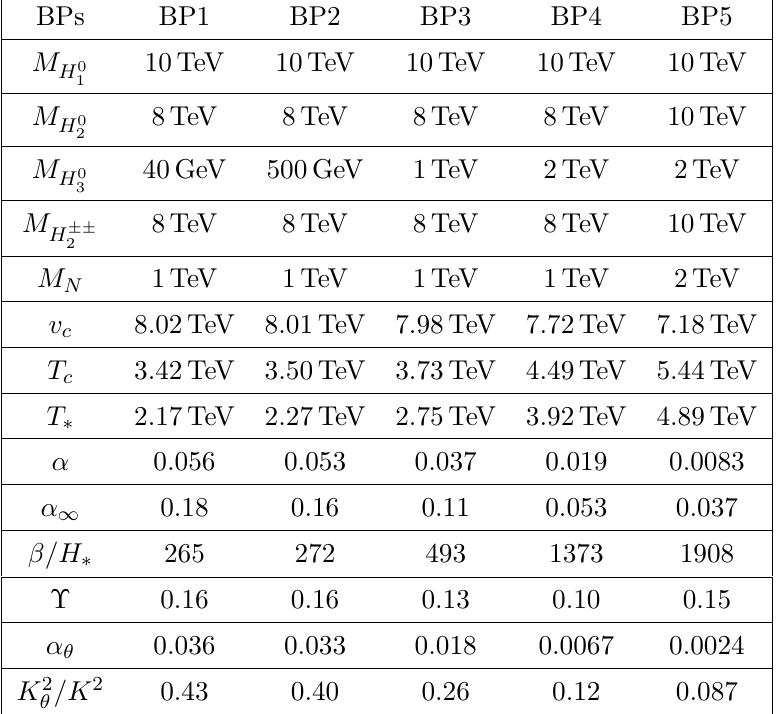
Table 2 . Five BPs studied in this paper. Parameters not shown in the table are set to be v R = 10 TeV, ξ = 10 − 3 , λ 1 = 0 . 13 , α 1 = α 2 = λ 2 = λ 3 = λ 4 = 0 . Their GW spectra are shown in figure 8. It is also noticed that all these BPs are non-runaway scenarios in term of the criteria defined in eq. (25) of [191]. The suppression factor Υ is defined in eq. (6.1) [197, 198]. Another suppression factor K 2 /K 2 of the M3 method derived from the trace of energy-momentum tensor θ and the corresponding α in refs. [199, 200] are provided in the last two θ